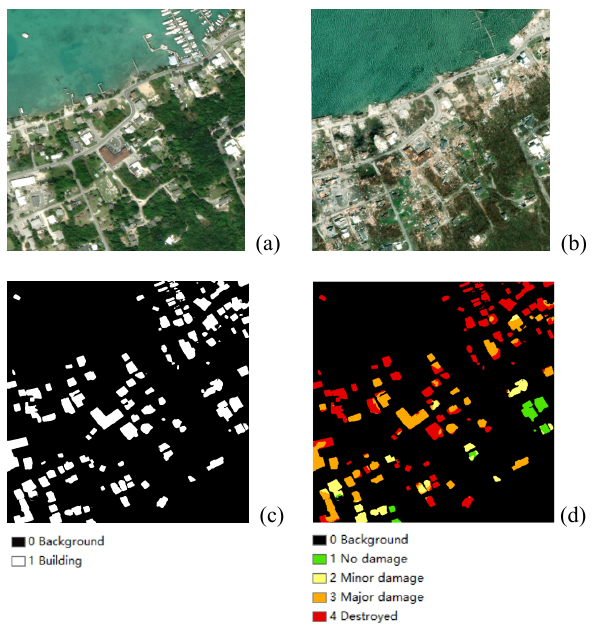
Figure 4. Model prediction results of Hurricane Dorian